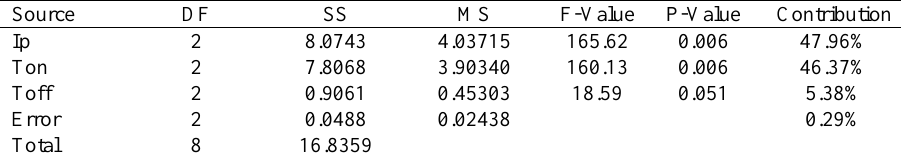
Table 7. ANOVA for S/N ratio of Cu electrode surface roughness.